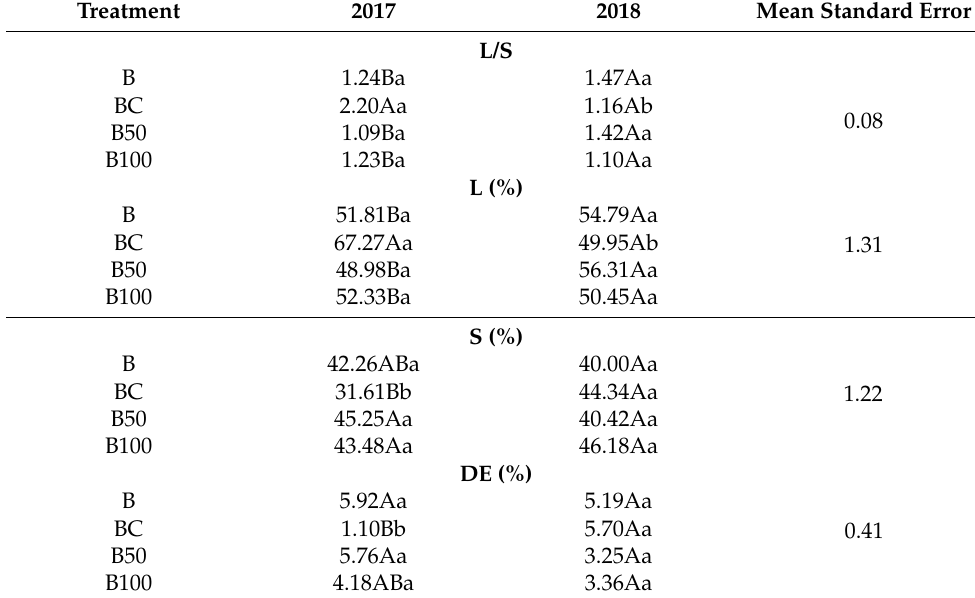
Table 7. Averages of the leaf blade/stem (L/S) ratios and percentages of leaf blade (L), stem, and dead material, via simulated grazing, for different treatments and experimental years at the end of the deferral period.